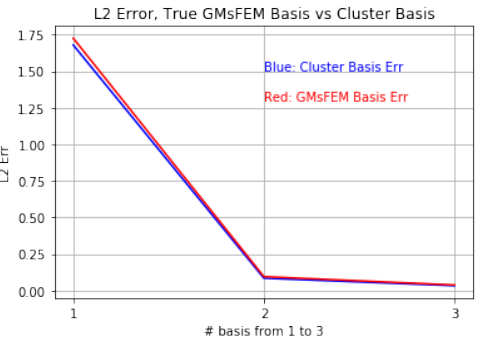
Figure 11. The l 2 error cluster solution (11 clusters) vs. solution by real κ ( x , ˆ s ) . Color represents number of